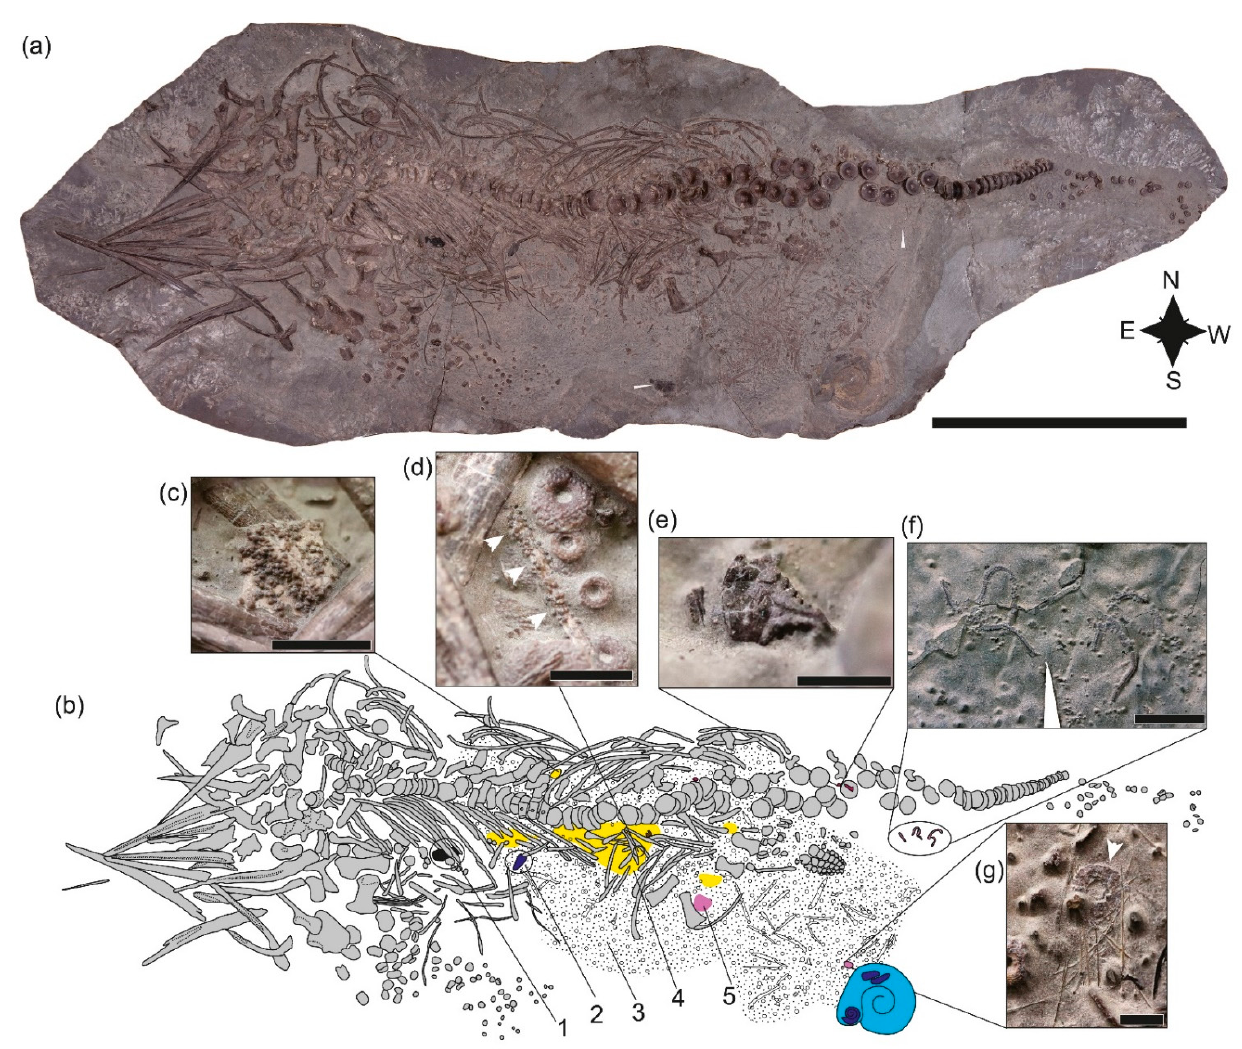
Figure 3. SMNS 80234, Stenopterygius quadriscissus , prepared from below. ( a ) Photo, copyright M. Wahler/SMNS. ( b ) Interpretive drawing. 1, driftwood in ribcage; 2, aptychus; 3, textured area representing scattered embryonic remains; 4, yellow shaded area showing the extent of the Reophax accumulation; 5, disarticulated ophiuroid remains. ( c ) Reophax accumulation; ( d ) Reophax encrusting an embryonic rib; ( e ) crustacean mandibular ossicle; ( f ) Sinosura brodiei ; ( g ) Diademopsis crinifera . Scale bars = 50 cm ( a ), 10 mm ( c ), 5 mm ( d , e , g ), 20 mm ( f ).